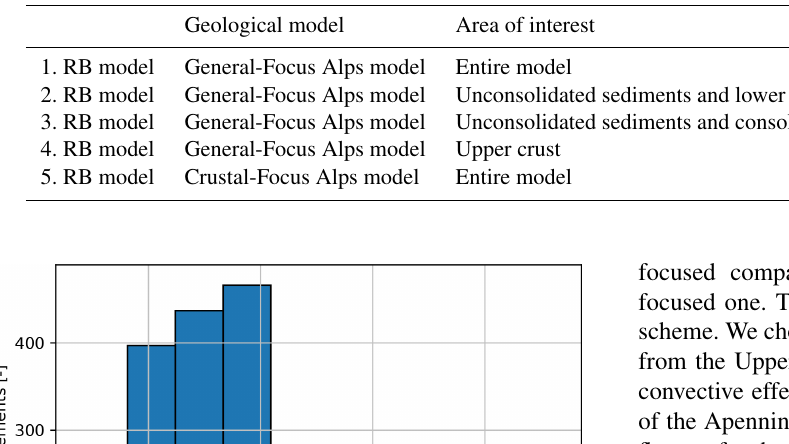
Table 1. Overview of the various RB models. Here we present the focus of the different surrogate models and their dimensions.